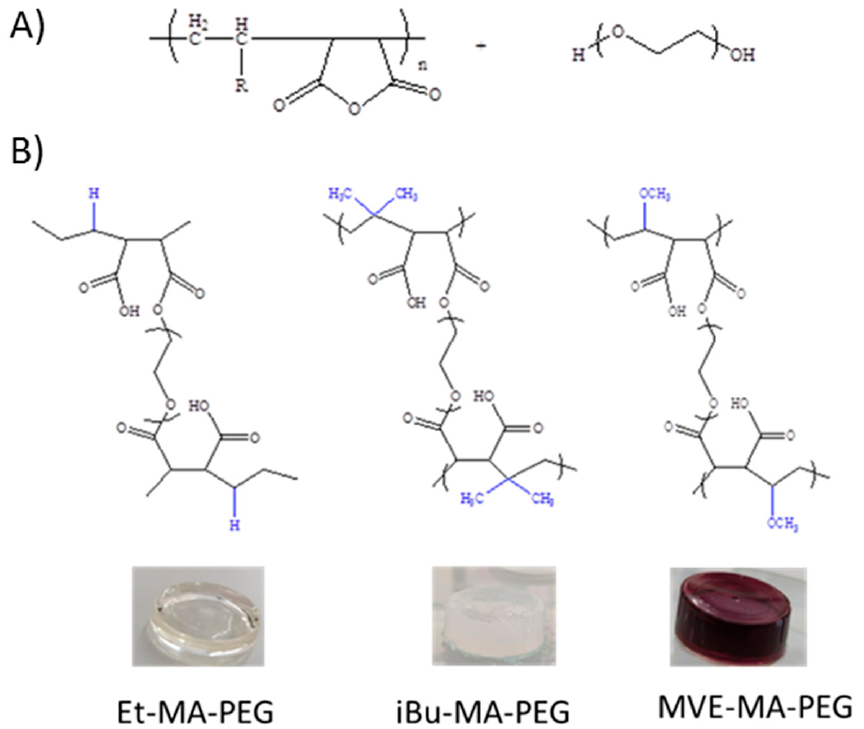
Figure 1. ( A ) Scheme of the general synthetic pathway for hydrogel formation; ( B ) chemical structures of the hydrogels prepared by maleic anhydride-based copolymers crosslinking with PEG. Once the hydrogels were formed, their chemical structure was evaluated by FTIR spec- troscopy. The Figure 2 shows the FTIR spectra of the copolymers and the obtained hydro- gels. The copolymers presented typical anhydride group bands around 1770–1850 cm − 1 , ascribed to C=O symmetric and asymmetric stretching, respectively [25]. After crosslinking, most of the anhydride groups reacted during esterification or remained as free carboxylic groups after being partially hydrolyzed [26,27]. The anhydride ring opening and the carboxylic acid formation could be observed with the disappearance of the band around 1850 cm − 1 for all the copolymers (blue rectangle at Figure 2). As could be observed, there was a shift in the characteristic peaks due to the carboxylic acid formation and the subse- quent esterification reaction with the reaction with the hydroxyl groups present on the PEG. The symmetric C=O band slightly shifted due to the free carboxylic acid formation around 1780 cm − 1 . However, this band was still close to the asymmetric C=O band of the anhy- dride. On the other hand, the esterification reaction between the carboxylic acid groups derived from the ring opening and the hydroxyls groups of the PEG were confirmed by the presence of the ester C=O stretching band at 1730 cm − 1 (red arrows at Figure 2) [25–27]. In addition, the presence of free carboxylic acids of the hydrogels and free hydroxyl of PEG is confirmed by a broad band of the OH stretching vibration around 3500 cm − 1